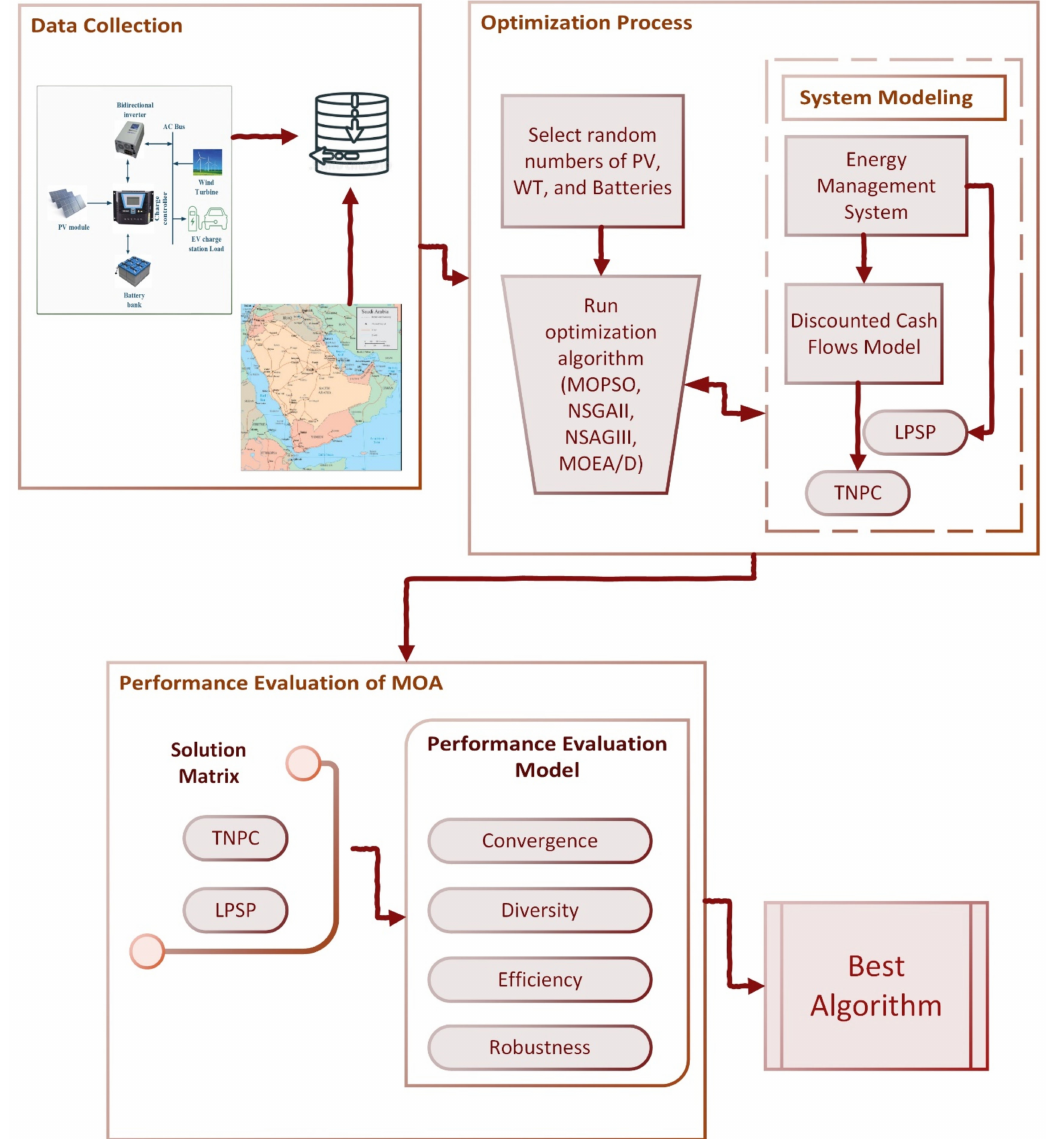
Figure 1. Framework of the adopted research